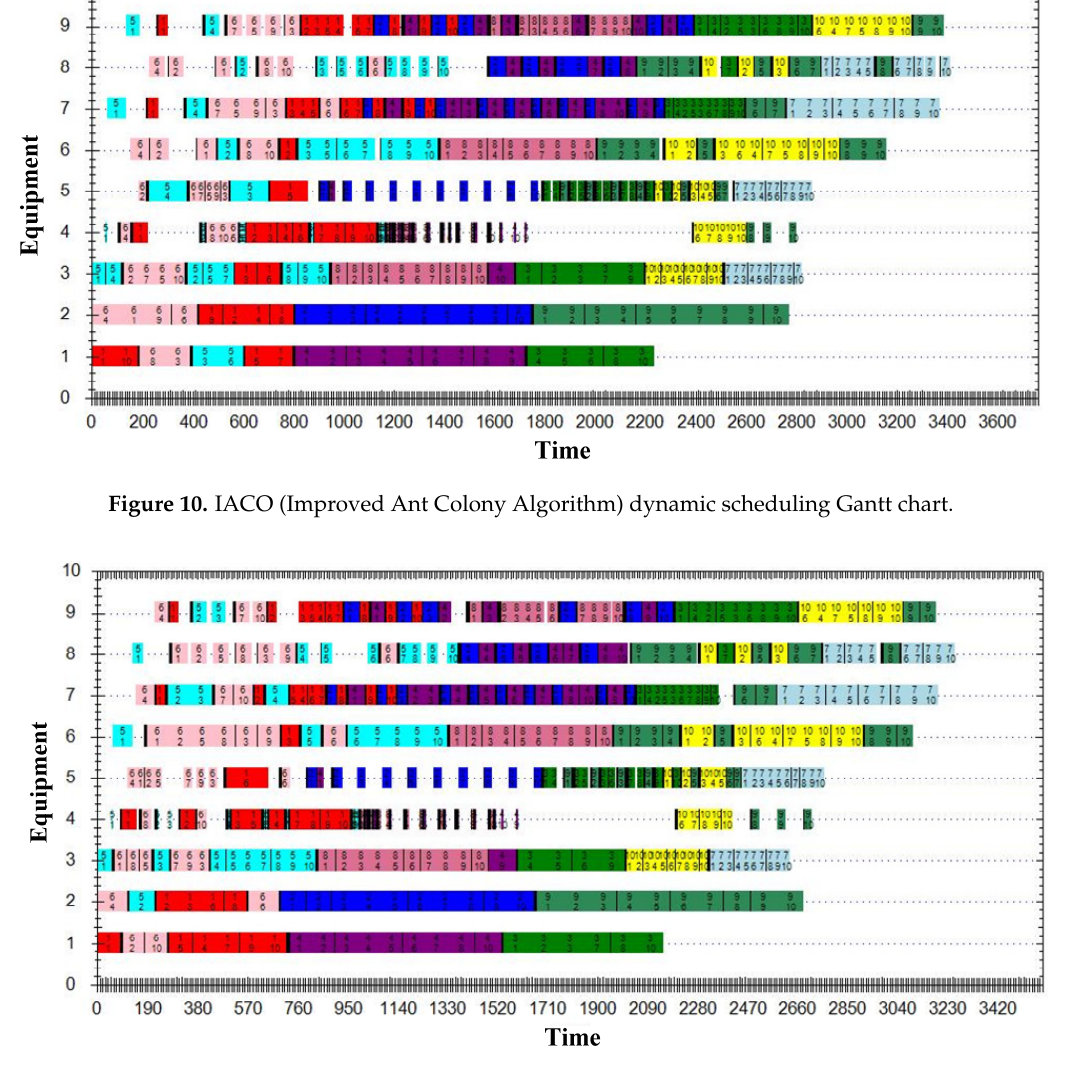
Figure 11. GRN-based dynamic scheduling Gantt Figure 11. GRN ‐ based dynamic scheduling Gantt chart.